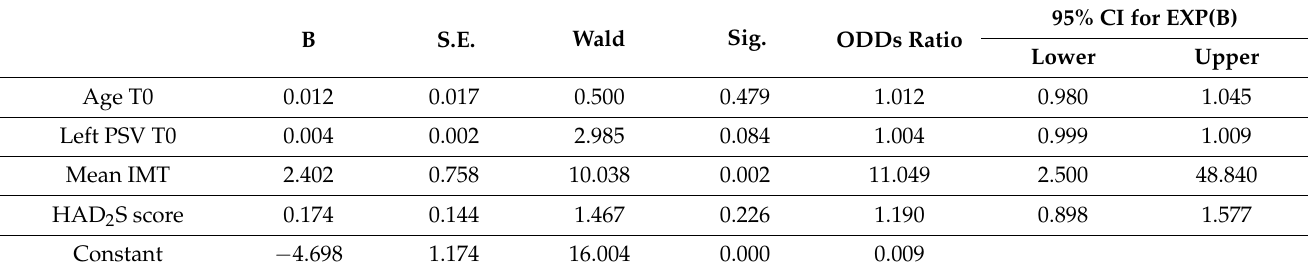
Table 3. Binary logistic regression analysis of independent determinants of plaque